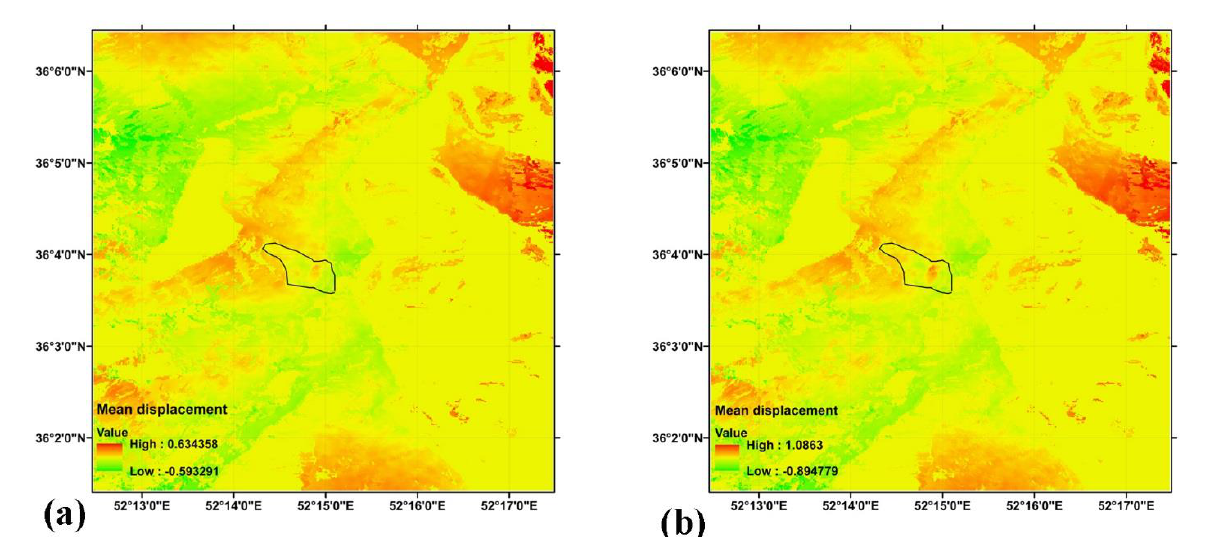
Fig 4 ( a) The mean displacement velocity map between 2006/09/24 and 2007/08/05; (b) The mean displacement velocity map between 20070909 and 2008/07/20. Black polyline shows the landslide